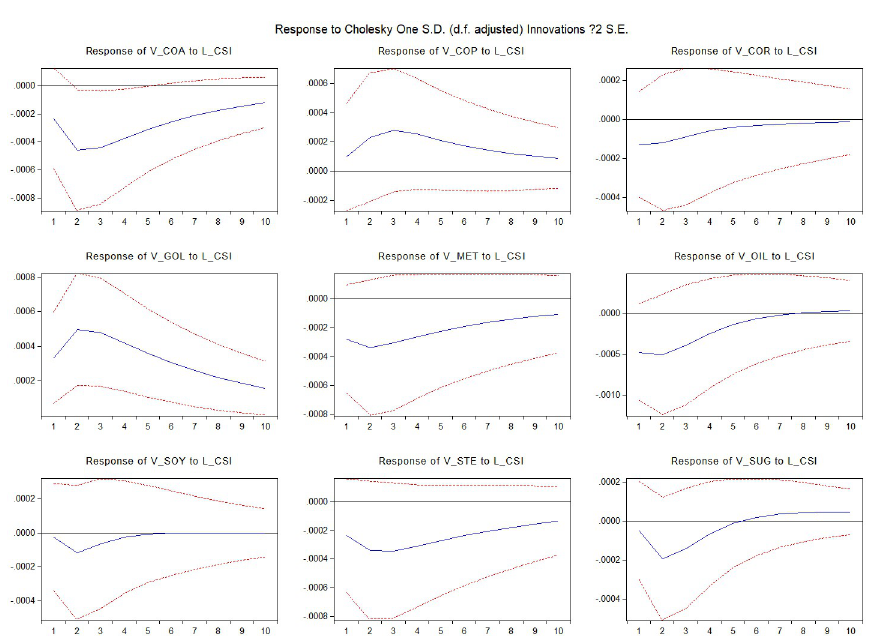
Fig 5. Impulse response functions of market i volatility to CSI300 index illiquidity. The figure presents the response of market i volatility (i = coa, cor, cop, gol, met, oil, soy, ste, sug) to CSI300 index illiquidity shocks. The sample runs from January 1, 2010 to March 22, 2021. The dotted lines are confidence bands based on Monte Carlo simulated standard errors.